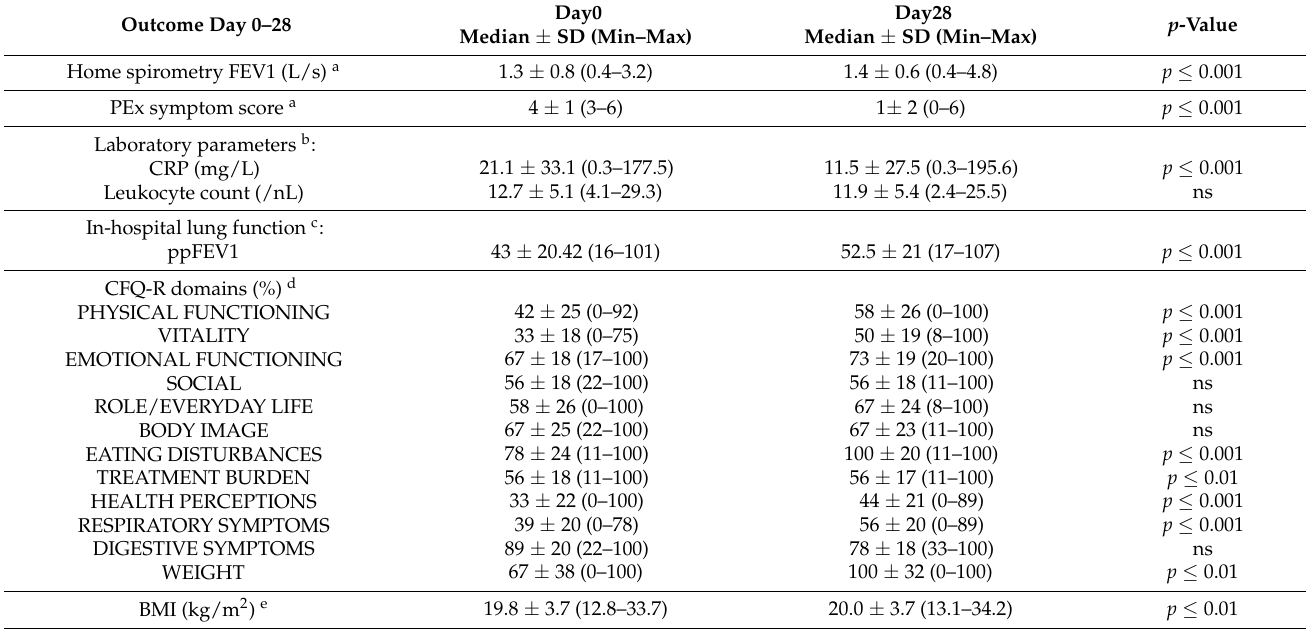
Table 3. Outcome days 0 and 28. Analysis shown for patients with complete data on days 0 and 28.